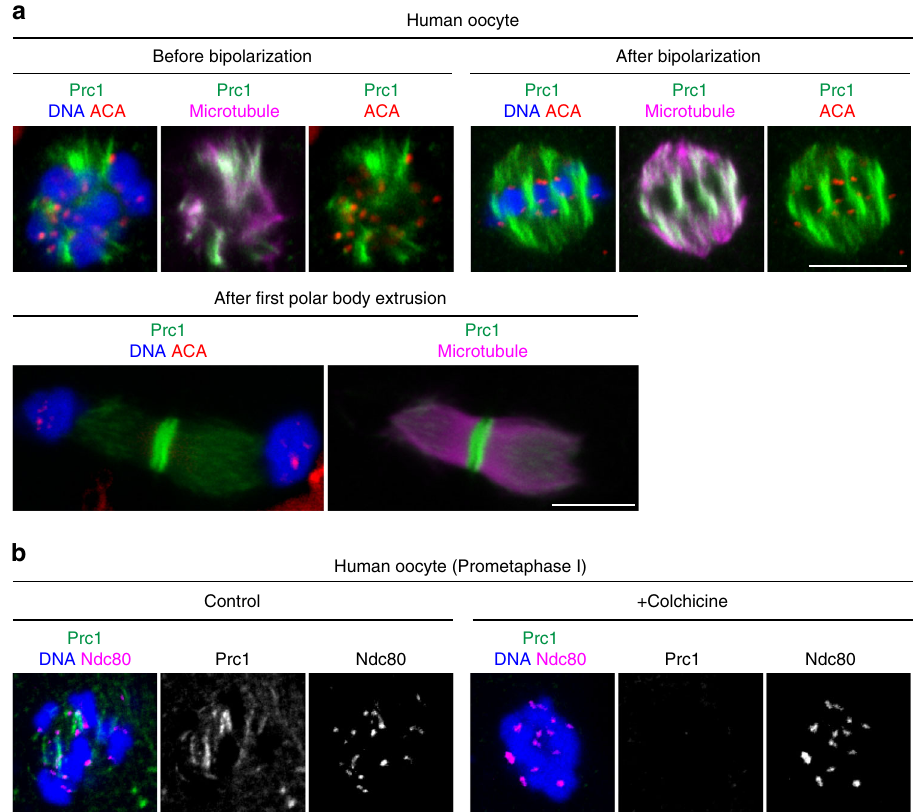
Fig. 7 Human oocytes do not exhibit detectable enrichment of Prc1 at kinetochores. a Prc1 localizes along spindle microtubules but not at kinetochores in human oocytes. MI oocytes of young women with no history of infertility were immunostained for Prc1 (green), kinetochores (ACA, red), microtubules (magenta) and DNA (DAPI, blue). Stages are categorized based on chromosome arrangement. Prc1 is detected at the spindle midzone after anaphase I. Oocytes from three women were examined. b Prc1 is not detectable at kinetochores. Human oocytes 5 h post NEBD were treated with the microtubule depolymerizer colchicine and immunostained for Prc1 (green), Ndc80 (red), and DNA (Hoechst33342, blue). Oocytes from more than three women were examined. Scale bars, 10 μ